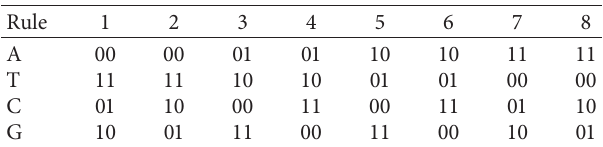
Table 1: DNA encoding rules. Table 2: DNA XOR operation rule based on DNA coding rule